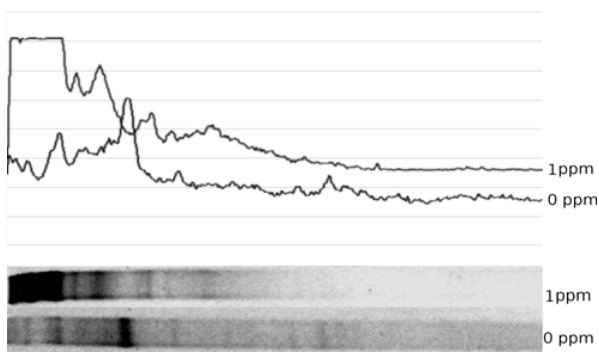
Figure 3: DGGE profile of nirK marker in low-Pb experiment. Bottom part, gel image; top part, digitized density profile of the gel